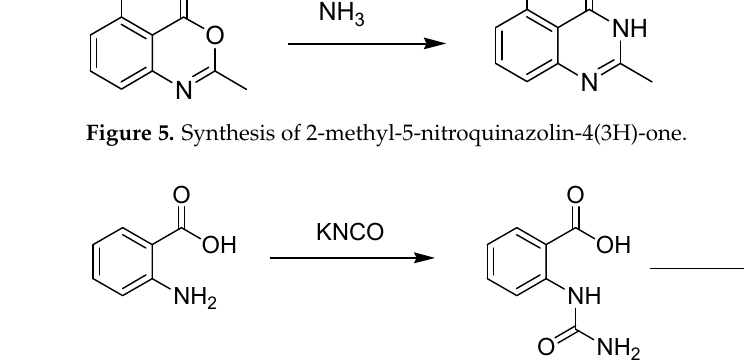
reacted to get o-ureidobenzoic acid followed by cyclization by heating with acid or (iv) Synthesis of 2-methyl-5-nitroquinazolin-4(3H)-one from 2-methyl-5-nitro-4H-